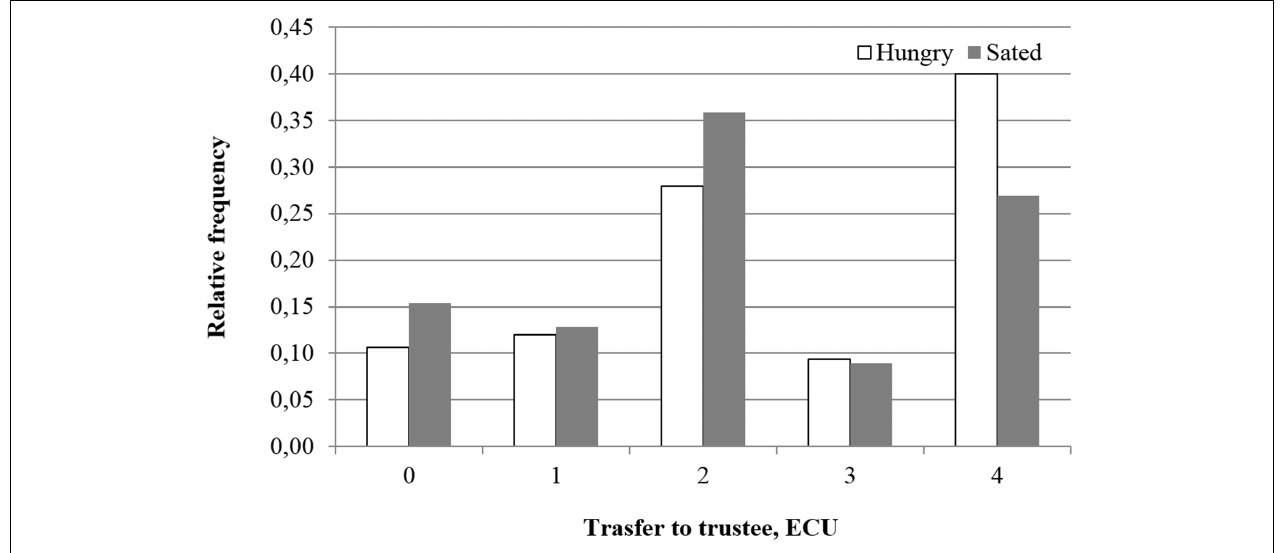
FIGURE 3 | Distribution of transfers to the trustee in the trust game reported separately for treatment (sated) and control (hungry) conditions. N = 153 ( N sated = 78, N hungry = 75).